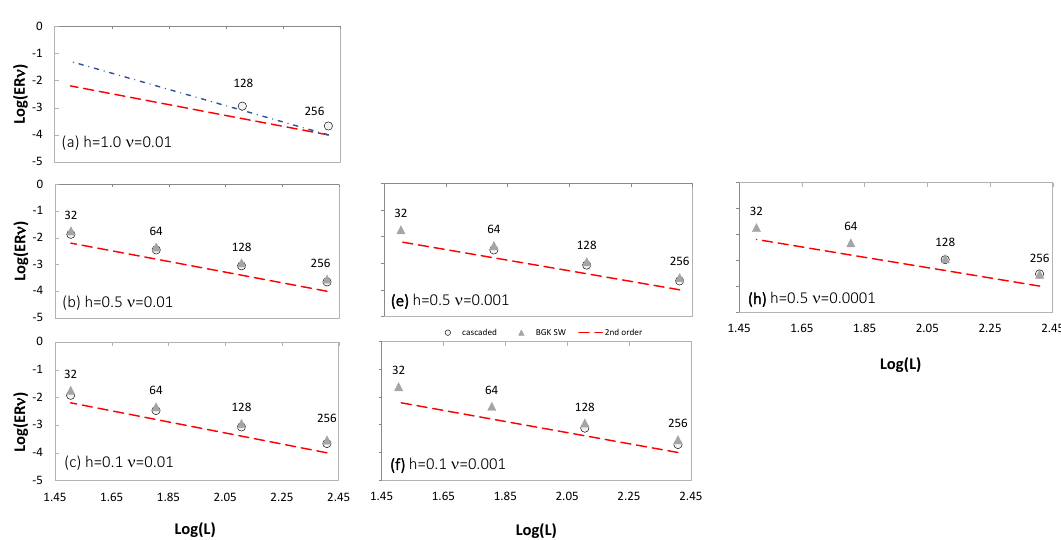
Figure A2. Taylor Green Vortex test. Fast velocity set—comparison of normalized error in viscosity ER ν , for the three depths: h = 1, 0.5, and 0.1 and three viscosities: ν = 0.01, 0.001, and 0.0001. The label shows the different values of the domain width L .